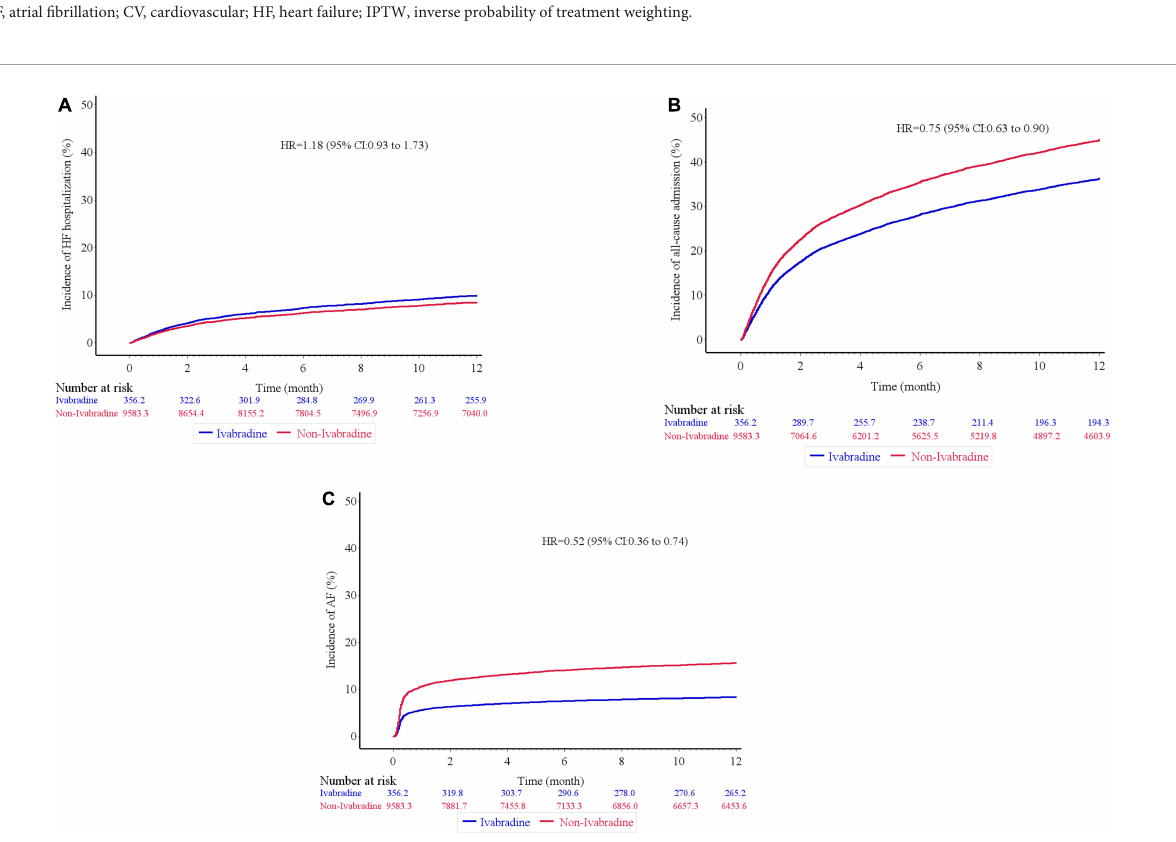
( Figure 4B and Table 3 ) between